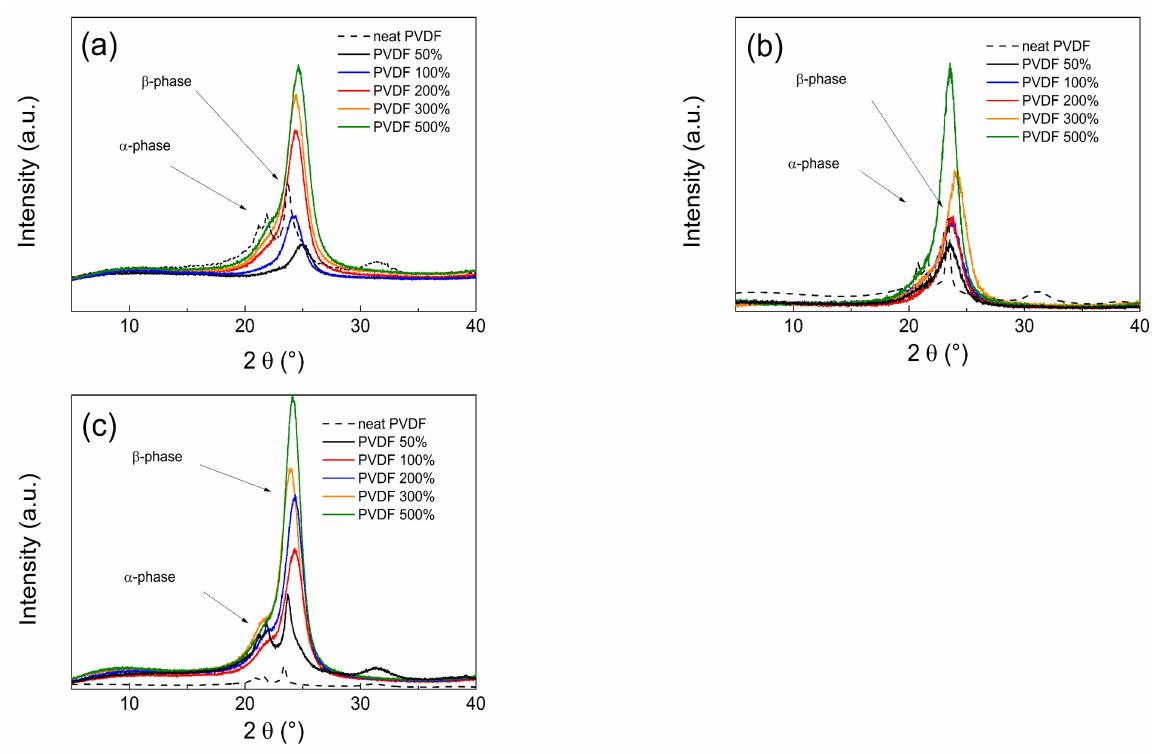
Figure 3. XRD spectra of the PVDF samples with the initial thickness of 0.5 mm and Mw of 180 kDa ( a ), 275 kDa ( b ) and 534 kDa ( c